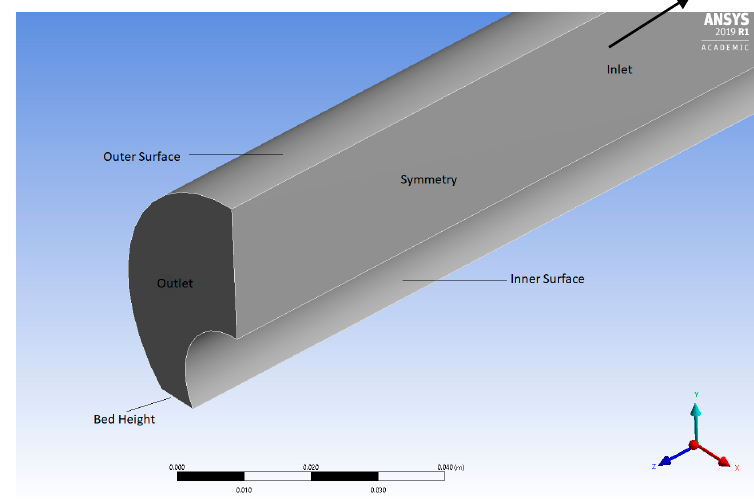
Figure 2. Named faces of the flow geometry [25]. Inlet (Fluid Inflow): The inlet face is named as inlet boundary (velocity inlet) located at the upstream end of the simulated wellbore at which the velocity profile is assumed uniform. Outlet (Fluid Outflow): A pressure outlet boundary condition is defined at the 3D geometries outflow, which is located downstream of the simulated